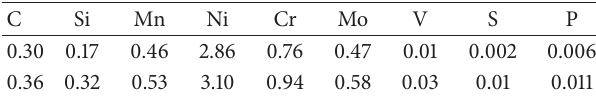
Table 1: Chemical composition for H-steel material according to DEFSTAN